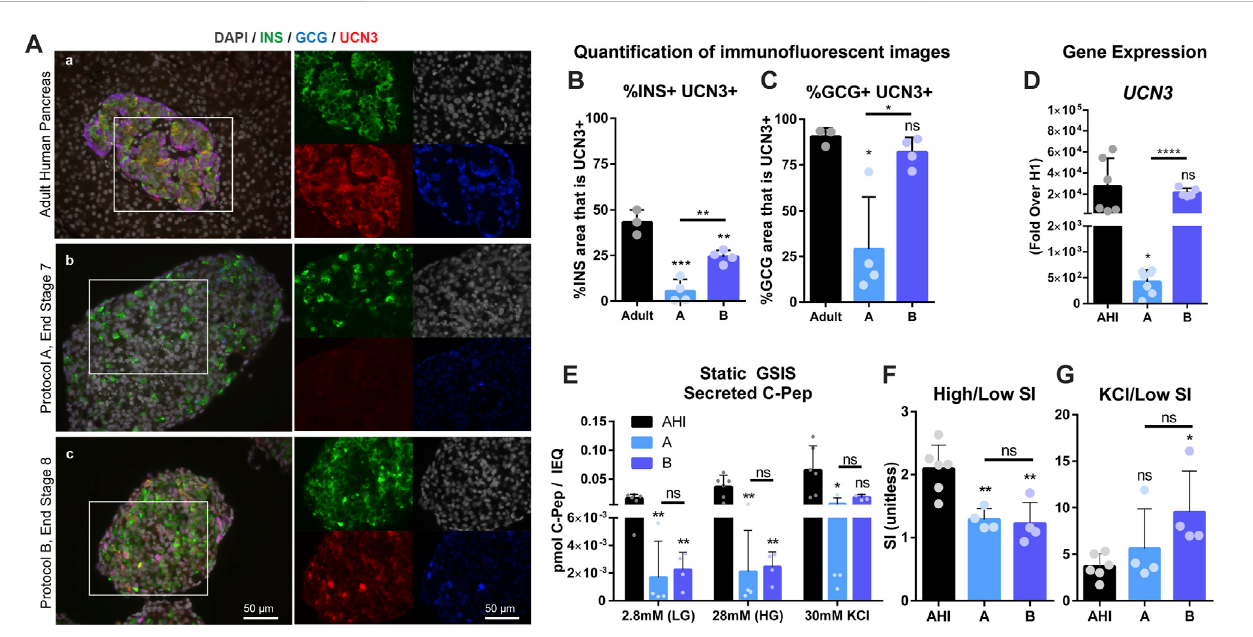
FIGURE 2 UCN3 expressionin SC-islets does not correlatewith improved function. (A) Immunostaining for insulin (green), glucagon (blue) and UCN3 (red) in adult human pancreas (A) , and end-stage cells collected after differentiation using Protocols A (B) and B (C) . Images of individual channels are the same magni fi cation as the merged images. Scale bars are 50 microns. (B) Quanti fi cation of co-localization of UCN3 with insulin in adult human pancreas, Pro A or Pro (B) . (C) Quanti fi cationofco-localization ofUCN3withglucagon inadulthumanpancreas, ProAorPro (B) . (D) Geneexpression of UCN3 normalized to beta-actin, in adult human pancreas and SC-islets derived via Pro A or Pro B relative to undifferentiated cells (H1). (E) Static GSIS assay to assess insulin secretion in response to low glucose (LG, 2.8 mM), high glucose (HG, 28 mM) and KCl (30 mM) measured by the concentration of human C-Pep in the